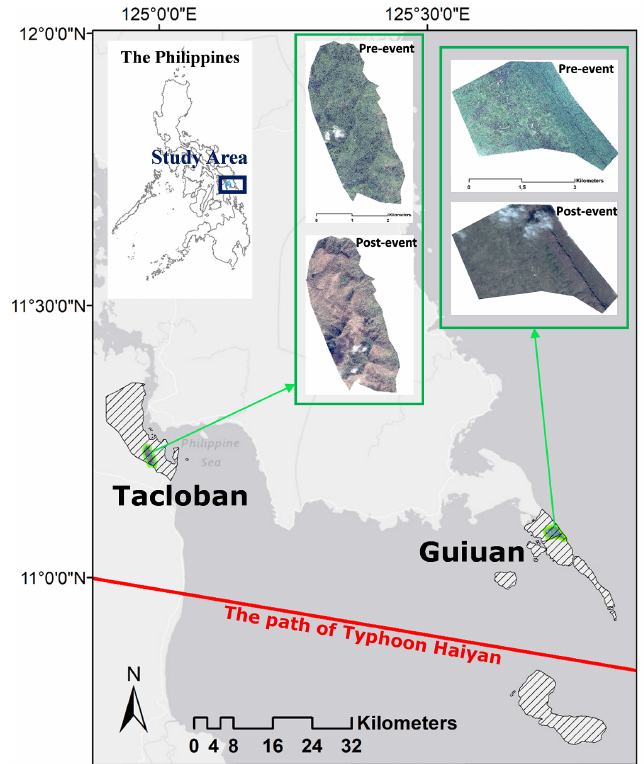
Figure 5. Locations of the study areas and the path of Typhoon